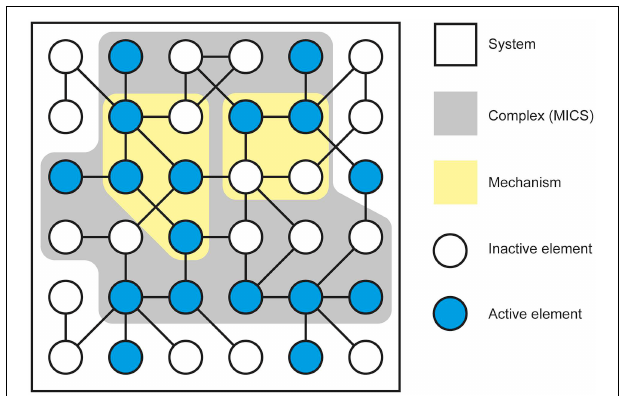
state of the mechanism is defined by the activity or silence of individual neural elements and determined by their causal interactions. The complex comprises the set of neural elements in the system that forms a maximally irreducible conceptual structure (MICS).